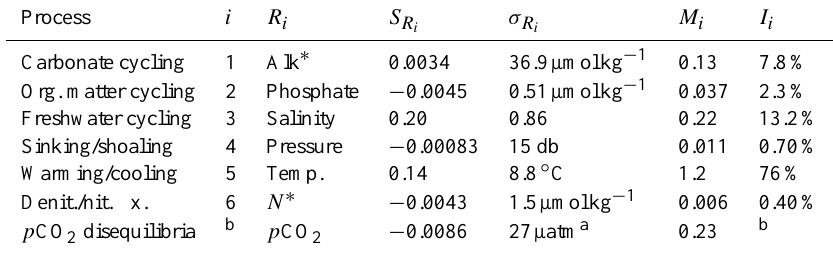
Table 2. Metric estimates M i , relative process importance percentages I i , calcite saturation sensitivities S R reference properties, and reference property standard deviations σ I details on how these terms are estimated and M i and I i uncertainties are